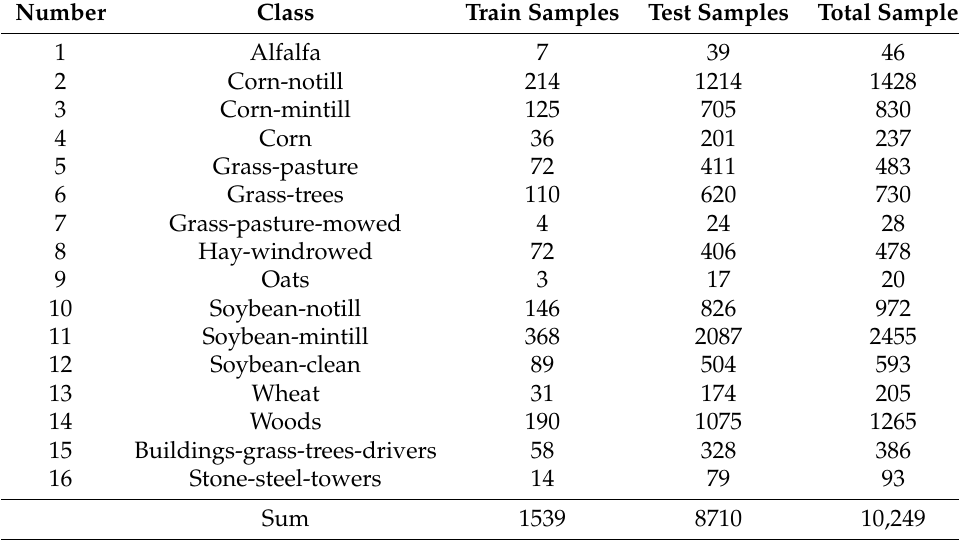
Table 1. The number of samples in the IP dataset.